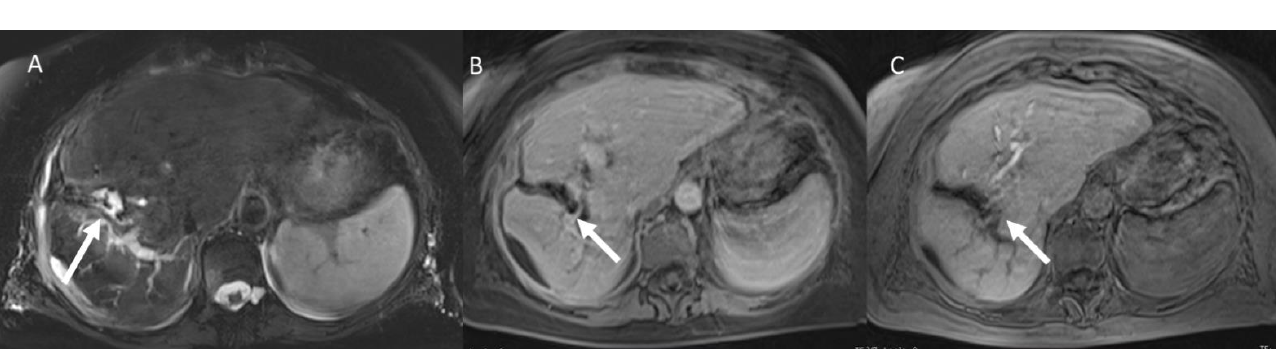
Figure 5. Woman 58 years at 1-week follow-up after microwave ablation of liver metastasis. MRI assessment. ( A ) Sampling perfection with application optimized contrasts using different flip angle evolution (SPACE) T2-weighted fat sat sequence in axial plane and ( B ) SPACE T2-weighted fat sat sequence in coronal plane, arrow shows biloma. In ( C ) CT evaluation (multi-planar reconstruction coronal plane) of biloma drainage (arrow).